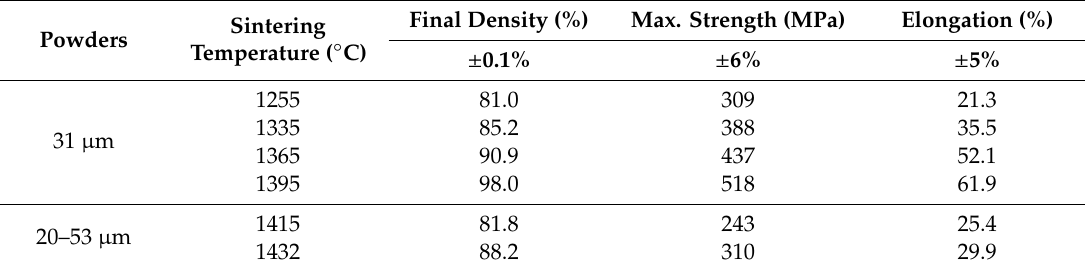
Table 14. Maximum strength and elongation of sintered tensile bars built with 31 µ m or 20–53 µ m